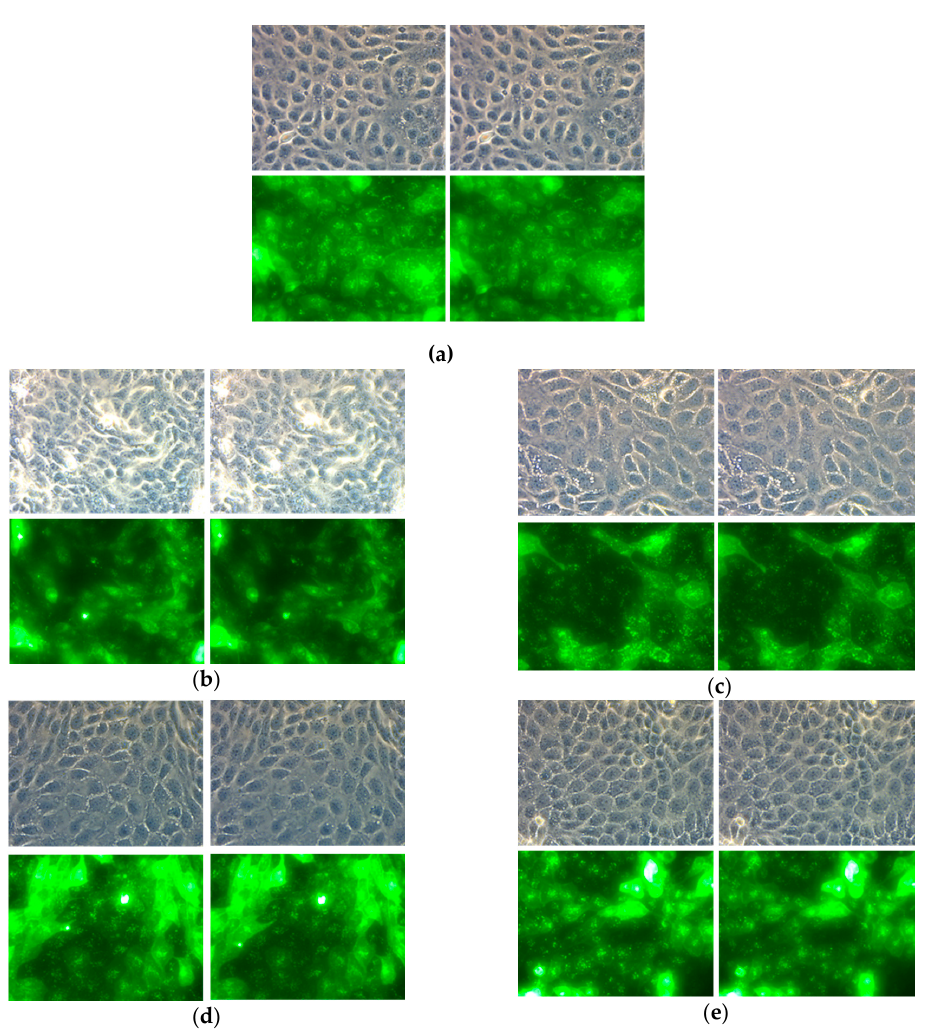
Figure 7. Change in cell shape the before (left) and after (right) (×63), phase contrast (top) and fluorescence (bottom) micrographs. ( a ) control treatment. ( b , c , d , e ) 0.3, 0.4, 0.5, 0.6 THz irradiation respectively.